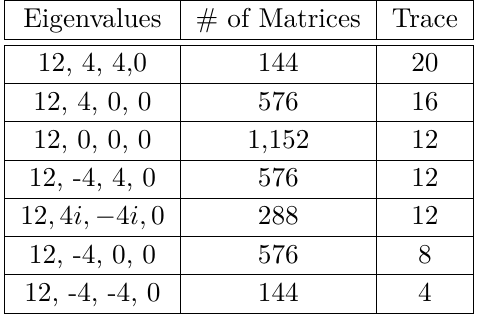
Table 28 . Eigenvalue equivalent classes of 3,456 distance matrices in class (2.4). Open